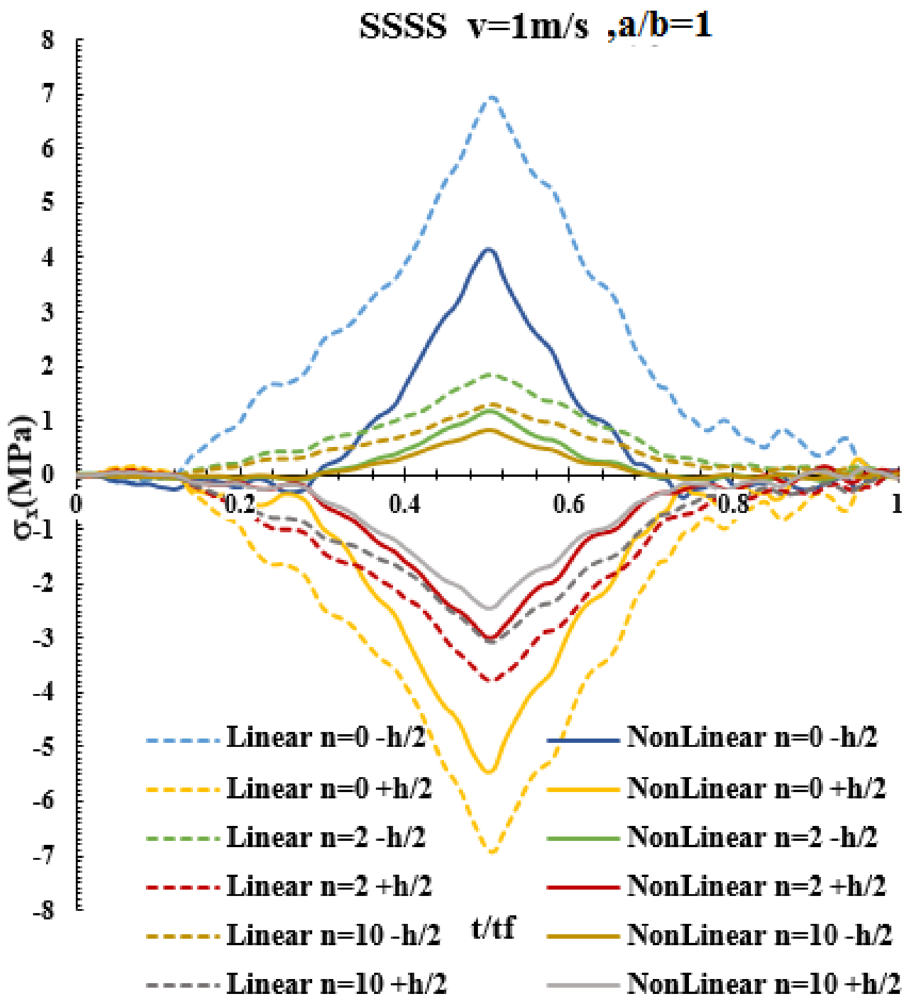
Fig. 20 The effect of material gradient index on transient dis- tribution of 𝜎 xx for center-point of the plate (SSSS, v = 1